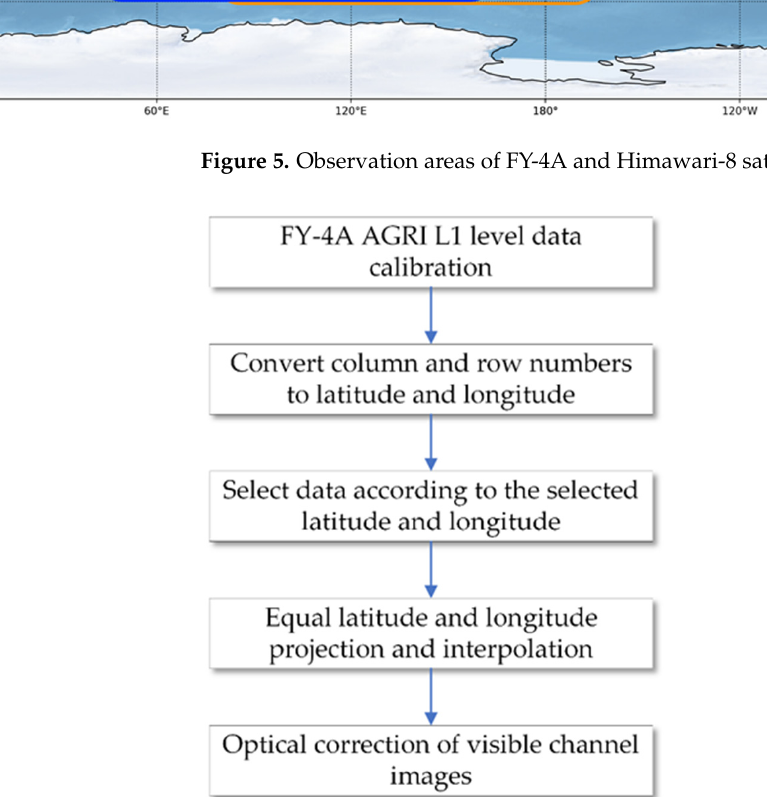
Figure 6. Data preprocessing process.